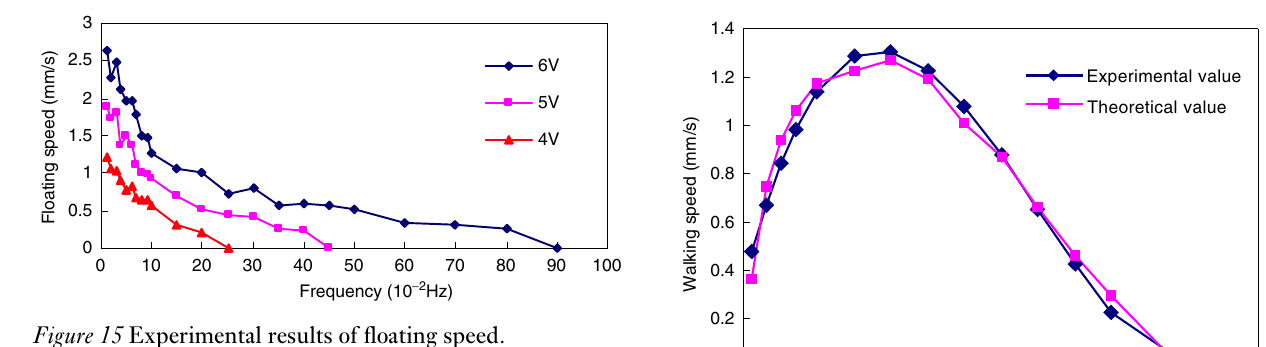
Figure 15 Experimental results of floating speed.